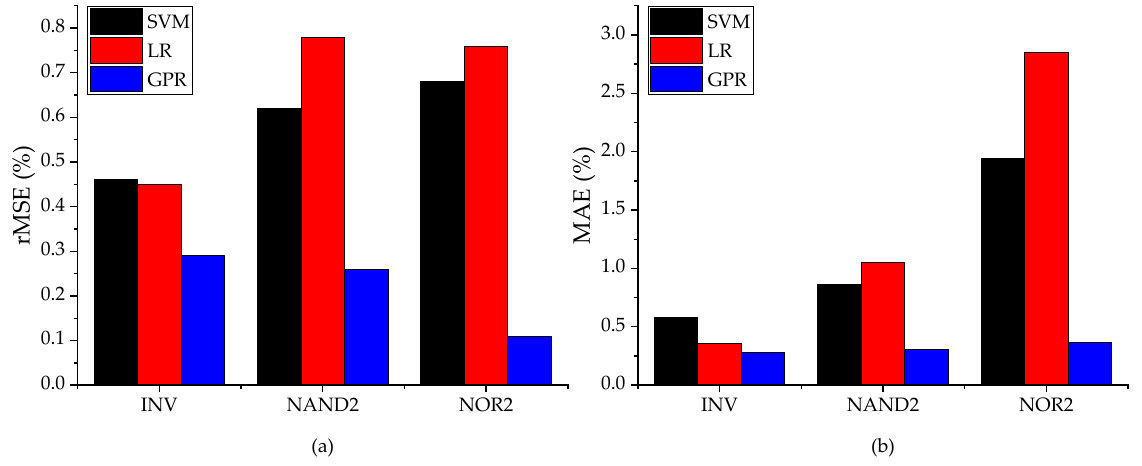
Figure 5. Accuracy comparation between different ML methods: ( a ) rMSE comparation ( b ) MAE comparation.